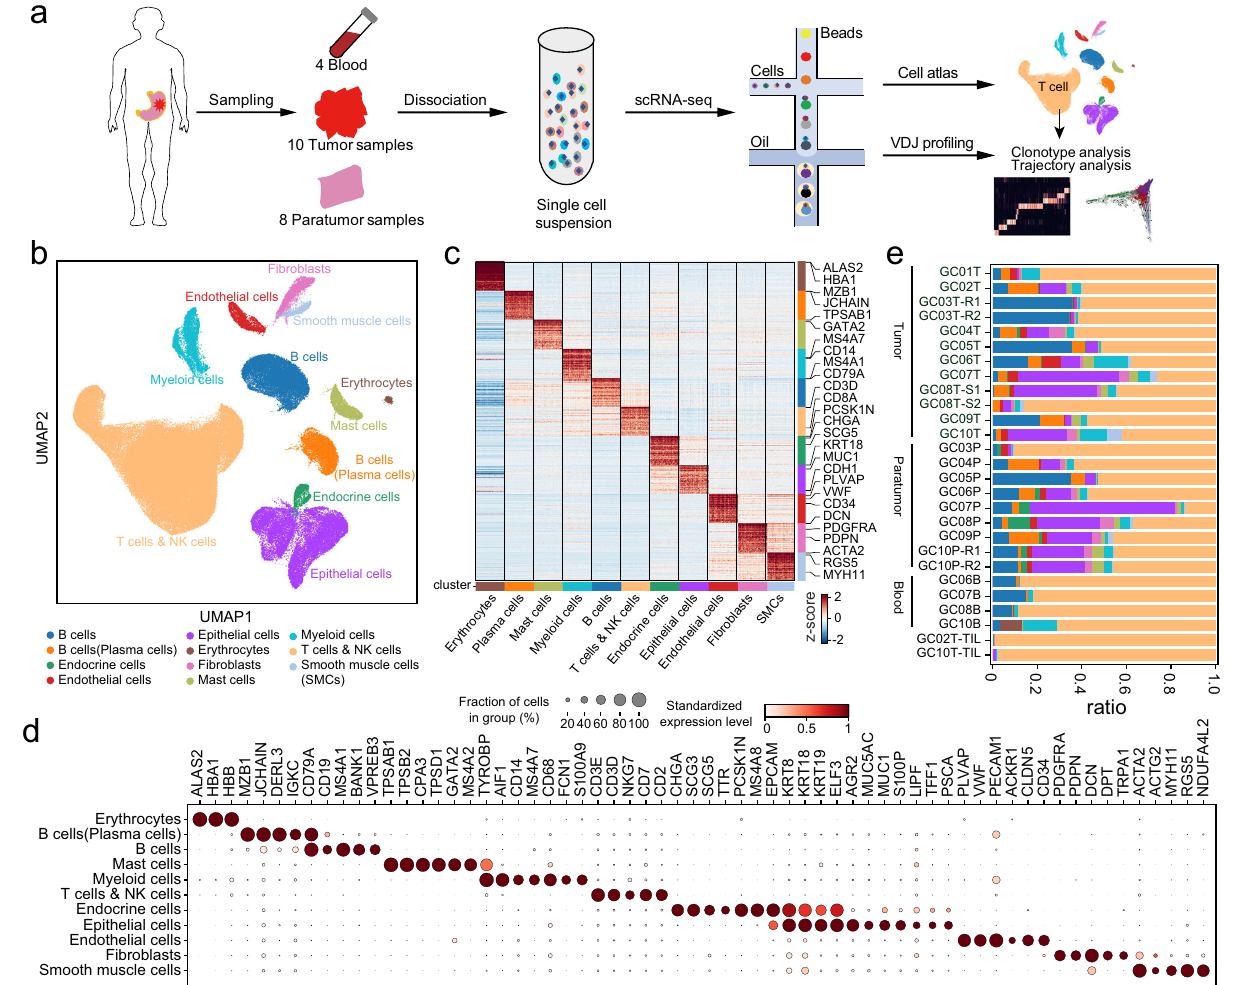
Fig. 1 | Characterization of the gastric cancer tumor microenvironment by scRNA-seq. a Work fl ow depicting sample processing and scRNA sequencing of gastric cancer (GC), peripheral blood, and paratumor cells and subsequent analy- tical methods. b Uniform Manifold Approximation and Projection (UMAP) of 166,533 single cells from 10 patients, colored by major cell types. c Heatmap showing the differentially expressed genes (rows) across major cell types (col- umns), with canonical marker genes indicated. d Dot plots showing marker genes